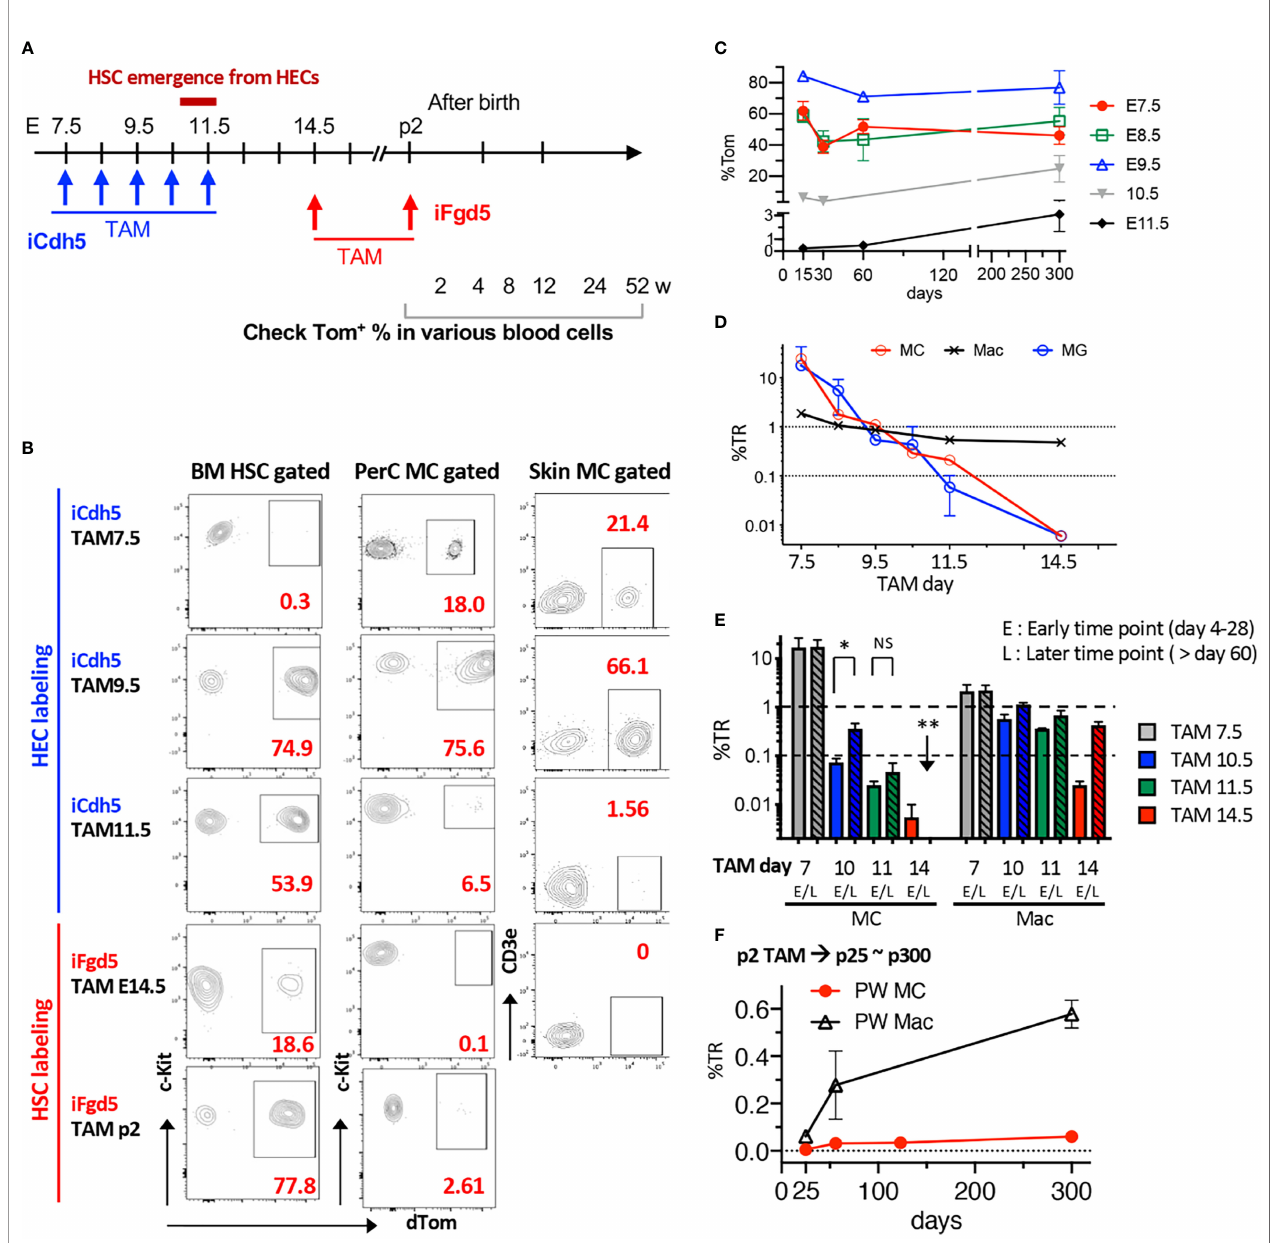
FIGURE 4 | Fate-mapping assays reveal an HSC-independent, but EC-dependent, origin for MCs. (A) Time points of TAM injection into iCdh5 or iFgd5 mice and various time points for analysis are depicted. (B) Representative fl ow plots for %Tom in BM HSCs, PerC, and skin MCs based on each TAM injection day (n=2-5 in each point). (C) Absolute percentages of Tom in PerC MCs were measured in iCdh5 mice. %Tom in various time points of analysis based on each embryonic day of TAM injection are plotted (n=3-7 in each point). (D) %TR of PerC MC, Macrophage (Mac), and Brain MG based on multiple TAM time points are plotted (n= 3-6 in each time point). (E) Kinetics of %TR of MC and Mac populations in PerC between early (<28 days) and late time points (>60 days) based on TAM injection day (n= 3-7 in each point). *: p<0.001(n=4). **: p<0.001 (n=3). (F) TAM was injected into p2 iFgd5 neonate and %TR of MC and Mac populations in PerC were plotted until one-year-old (n=3 in each point). ns, not signi fi